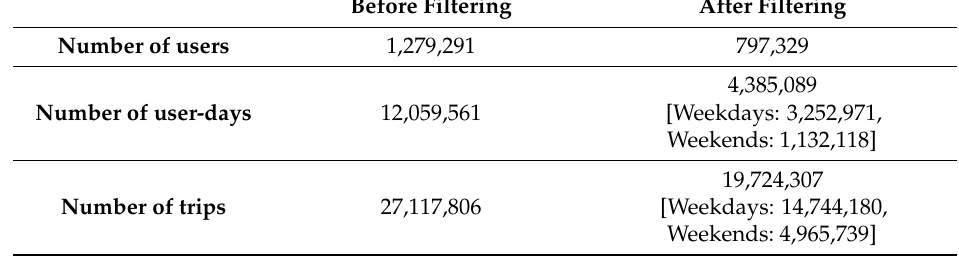
Table 4. Statistical summary of user sample before and after filtering valid user-days.